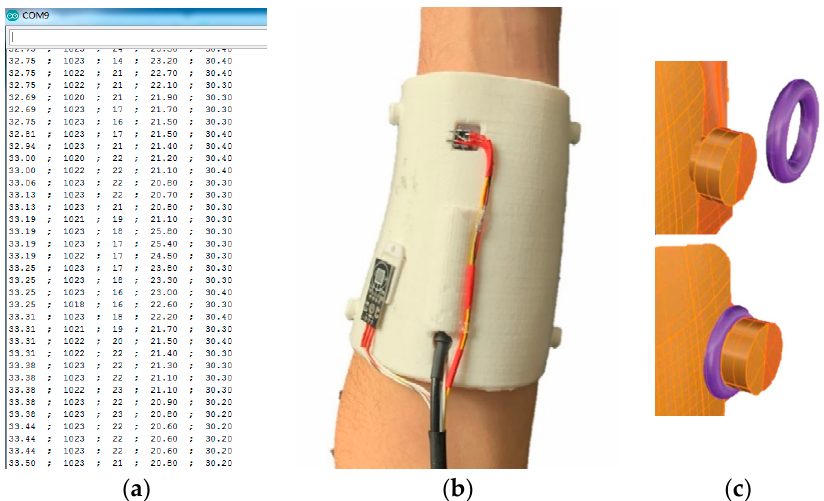
Figure 10. Example of the serial data collection using the Arduino board ( a ), real splint prototype with electrical wiring mounted over the arm ( b ) and detailed view of the closing buttons ( c ).